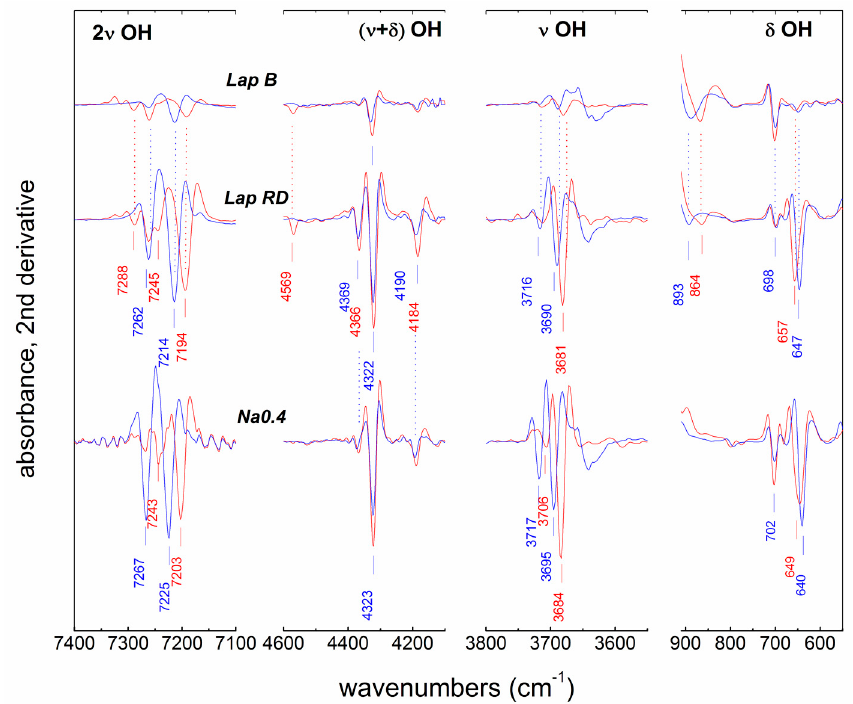
Figure 5. Details of the second derivative ATR and NIR absorbance spectra of LAP B, LAP RD, and Na0.4 over the bending, stretching, combination and overtone ranges of structural OH. The “wet” and “dry” spectra are depicted in blue and red, respectively. The spectrum at ambient conditions is intermediate to the two end-members. The spectral pairs are offset for clarity but share the same y-axis scale. Table 2. Characteristic positions (cm − 1 ) of stretching, bending, combination and overtone modes of structural OH in “wet” and “dry” non-fluorinated smectites. Anharmonicities (X) are also provided. Talc and sepiolite (SepSp-1) data are added for comparison (from [30]). LAP D, -ED, -RD,